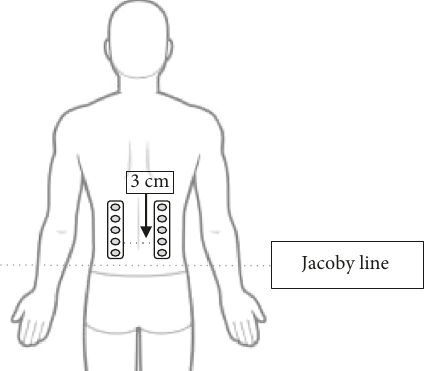
Figure 2: Approximating the EMG lattice location. A 3 cm side-by- side EMG electrode grid was placed on the lumbar spinous process.